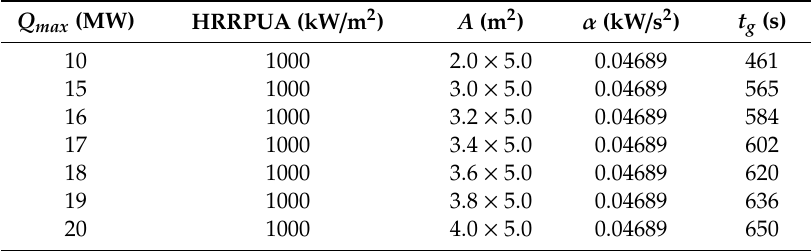
Table 2. Parameter settings of fire source. HRRPUA = heat release rate per unit